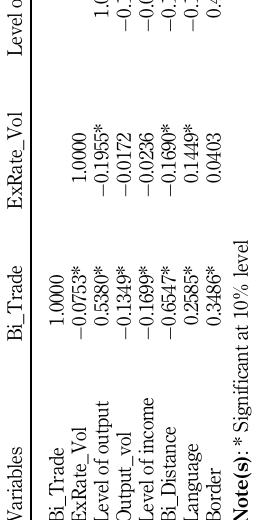
Table 3. Correlation matrix